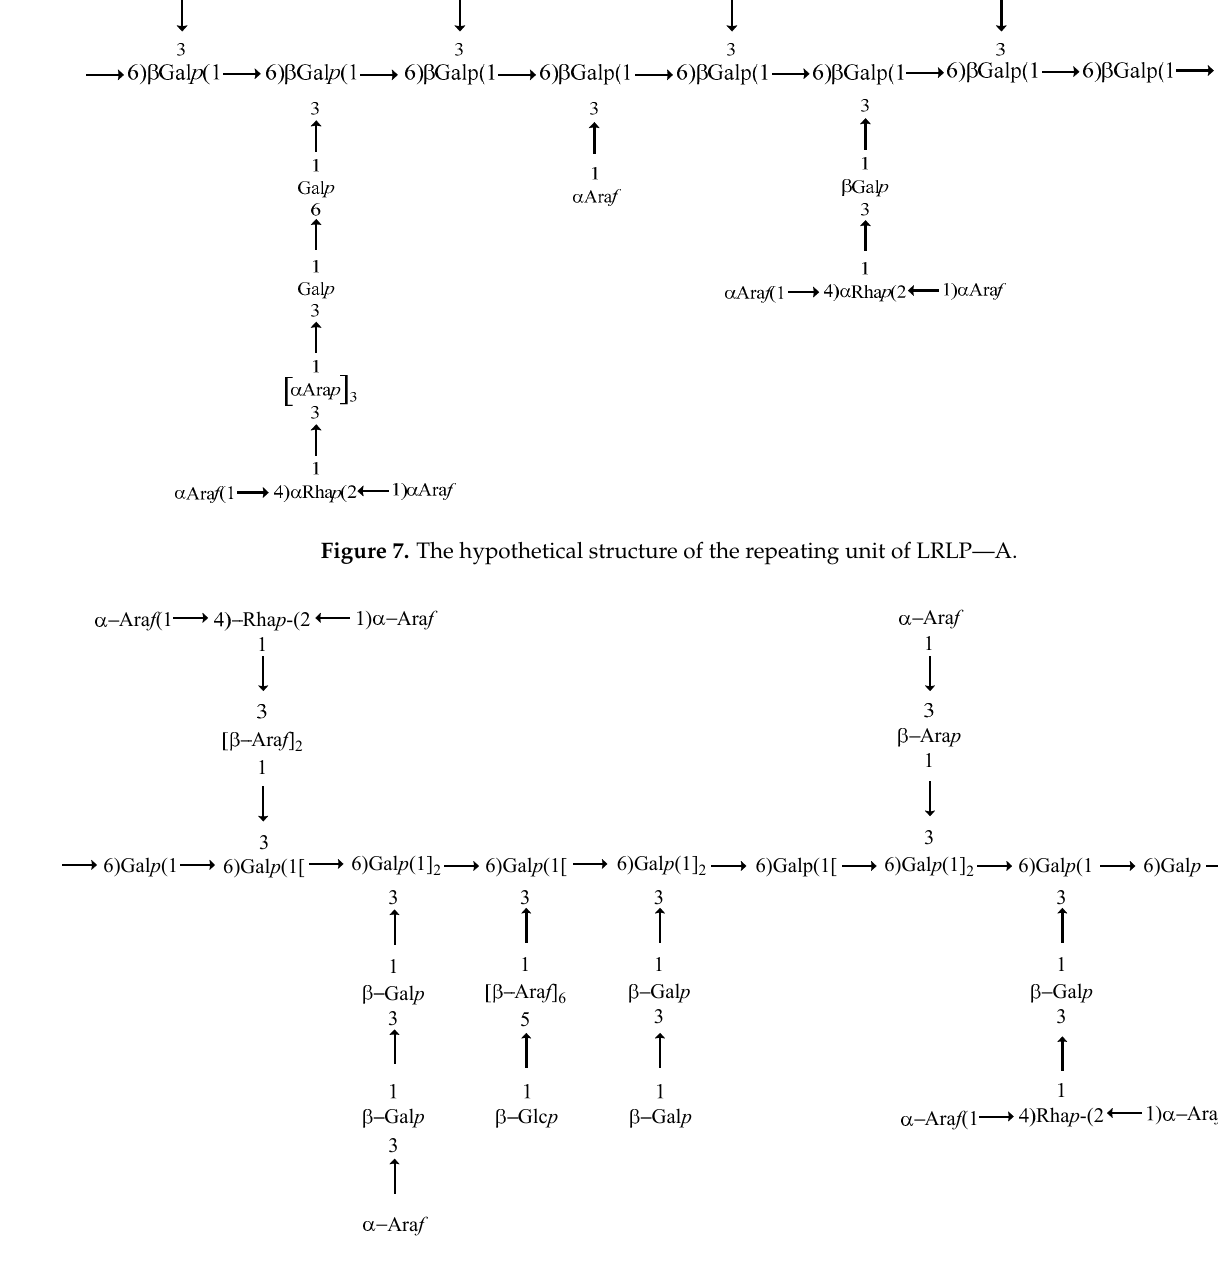
Figure 8. Schematic representation of the structural unit of LRP4-A.